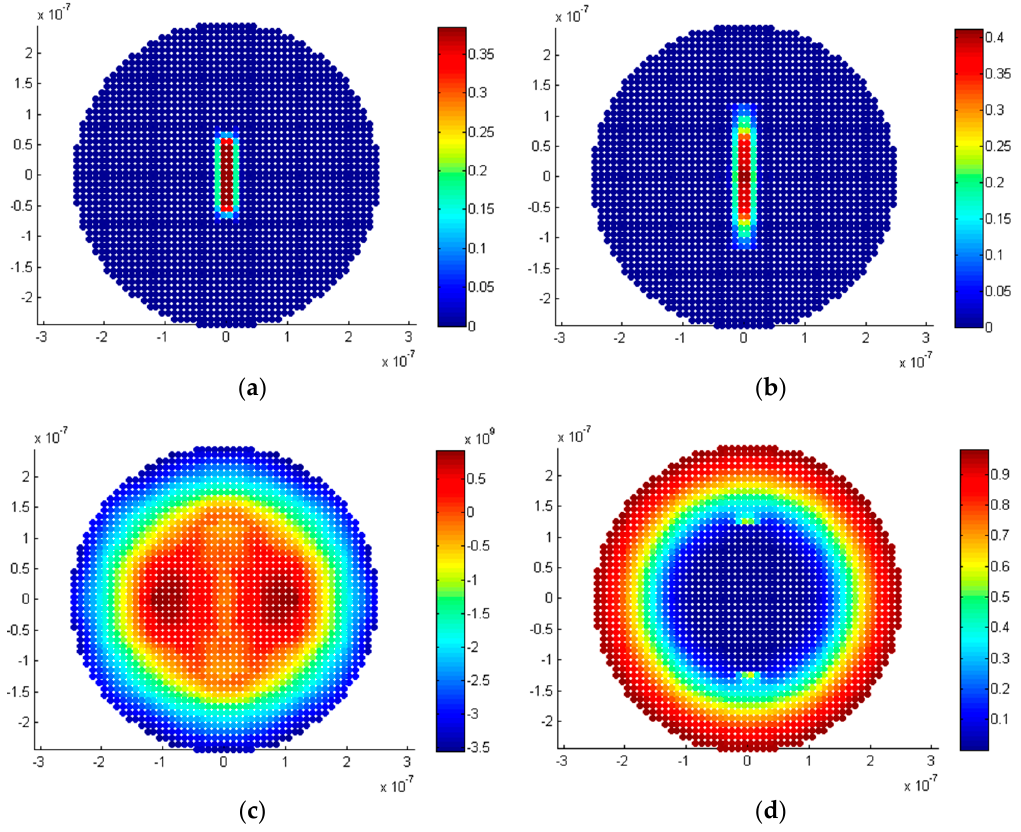
Figure 11. Result plots of cylindrical anode with a single vertical crack in the x - y mid-plane: ( a ) initial damage; ( b ) damage after deformation; ( c ) hydrostatic stress; and ( d ) lithium ion concentration.